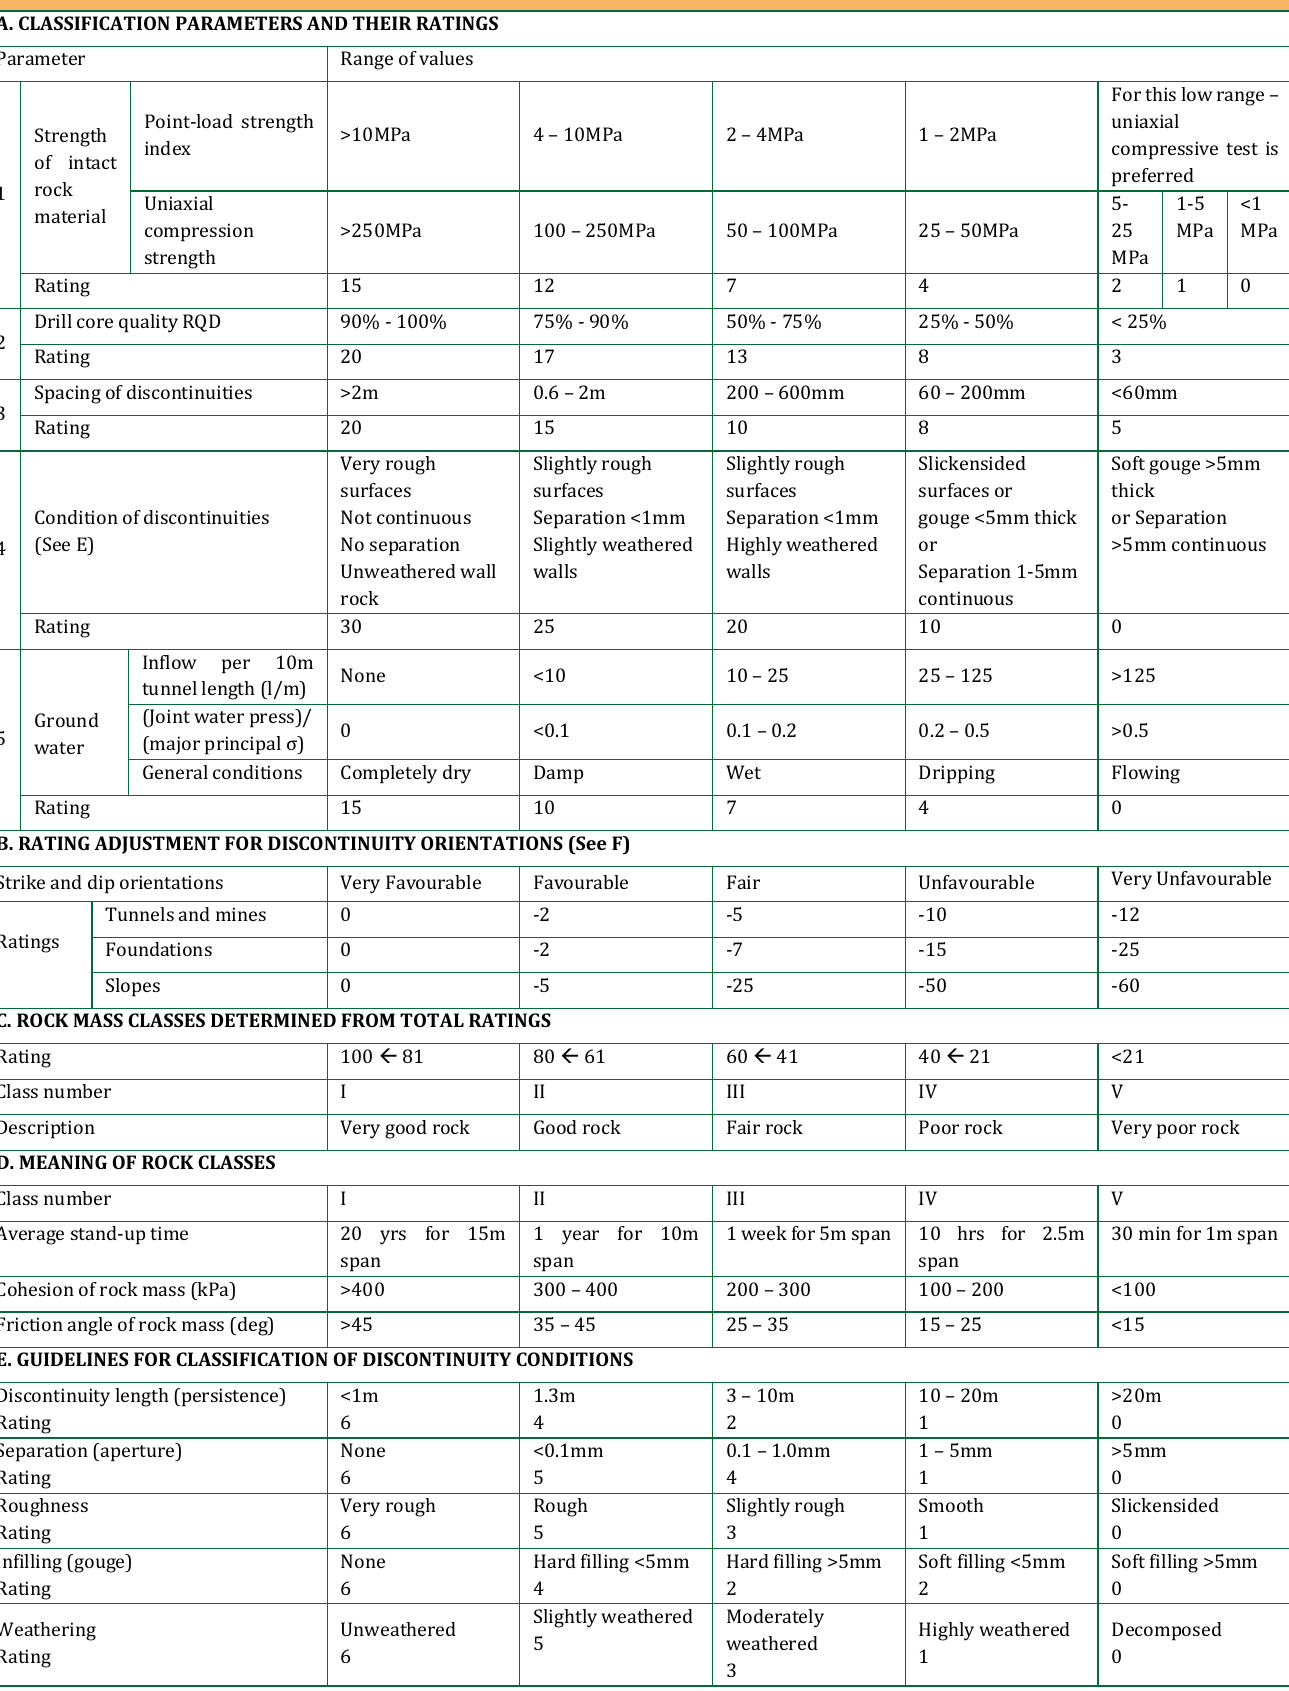
Table 1: Rock mass classification RMR system (Bieniawski,